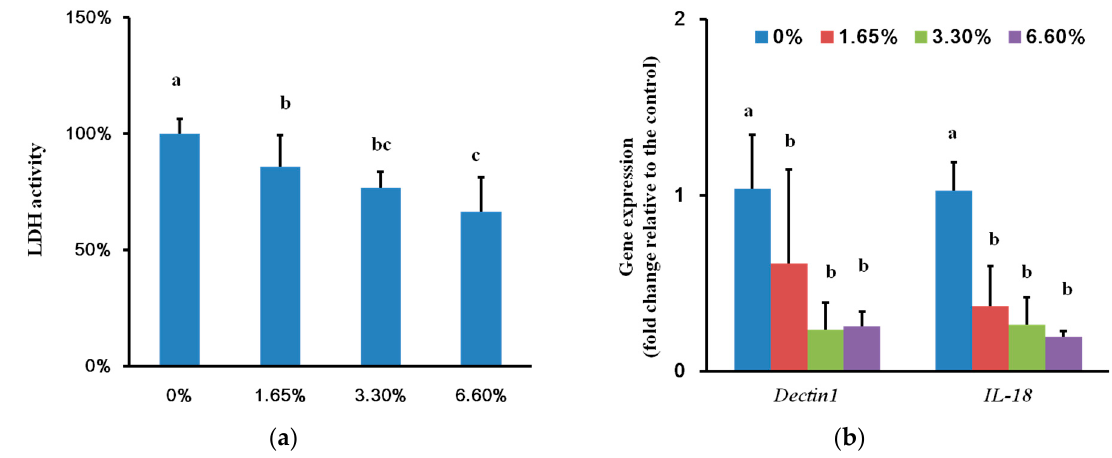
Figure 4. Cell damage based on lactate dehydrogenase (LDH) activity and relative gene expression of TR-146 cell: ( a ) Cell damage based on LDH activity after co-culture with biofilm formed on different DMADDM containing groups; ( b ) Relative gene expression of TR-146 cell after it was co-cultured with biofilms of different groups. Values are significantly different when labelled with different letters ( p < 0.05).